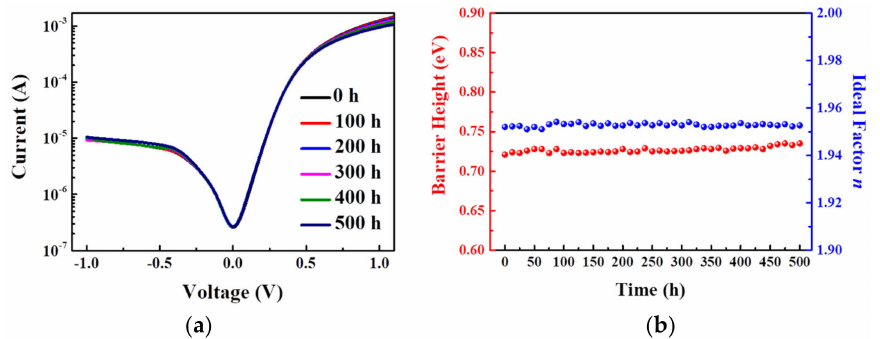
Figure 7. ( a ) I–V characteristics for a Pt/CP/n-Ge Schottky diode for different DC stress (0.1 A) times and ( b ) Φ B and n as a function of stress time, as obtained from the diode equation (1): the measurements were performed at room temperature in ambient